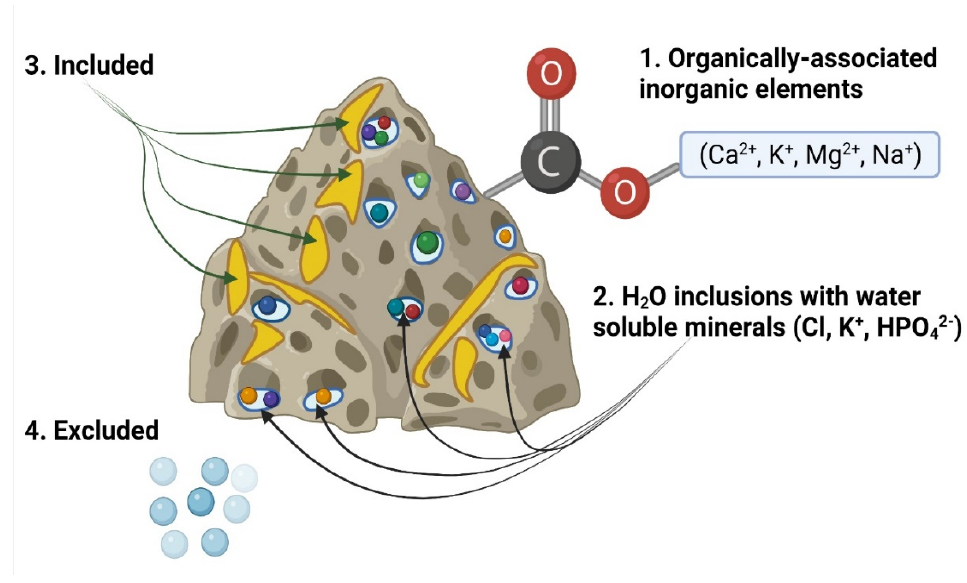
Figure 2. Inorganic constituents in biomass and their occurrence [28,36].